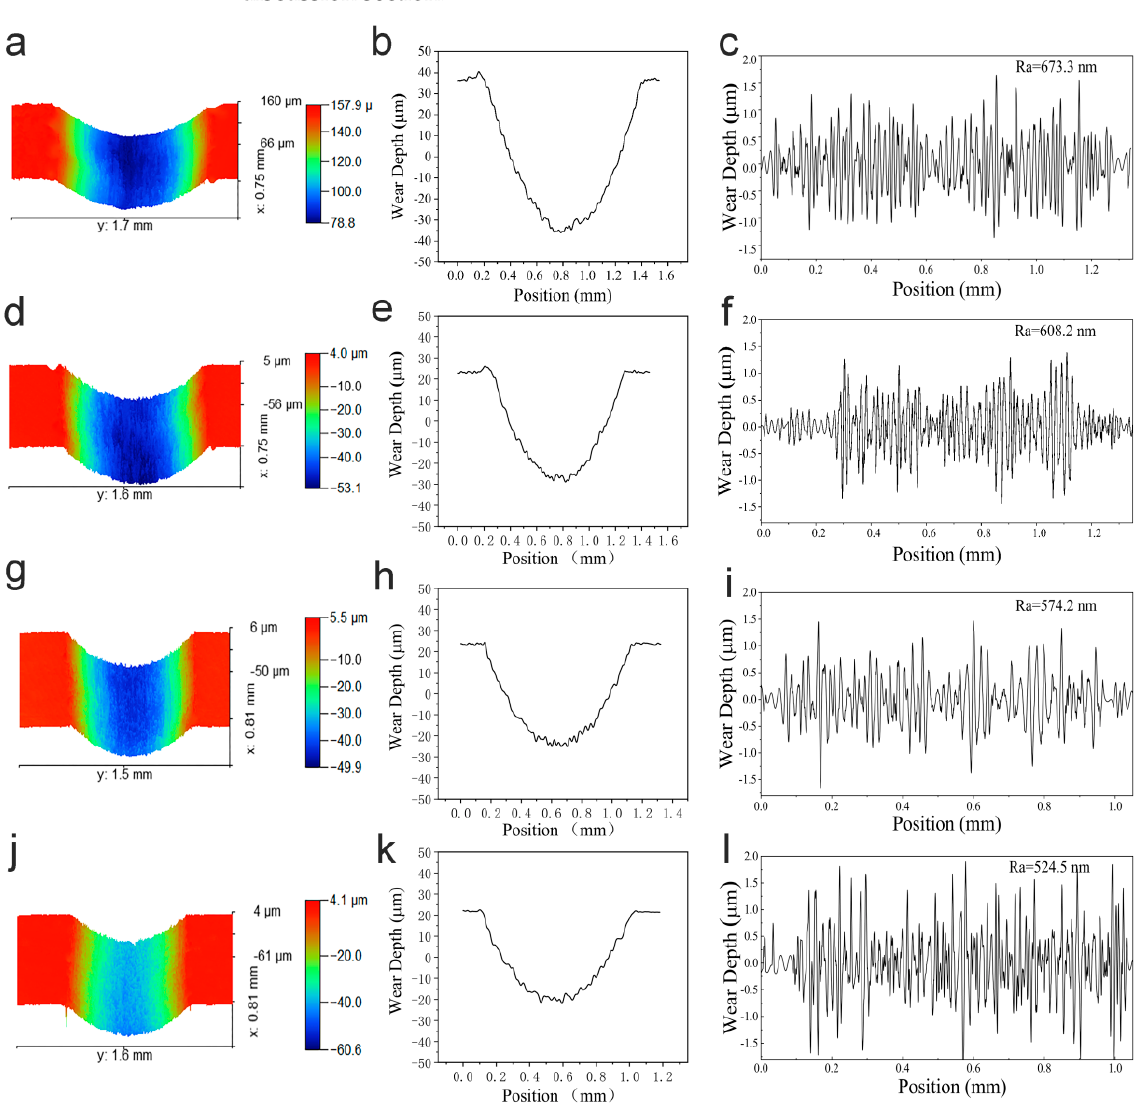
Figure 9. Three-dimensional topographies, the wear scar profiles and the worn surface roughness that are perpendicular to the sliding directions in the Al-5 wt.% CrCoNi composite ( a – c ), Al-10 wt.% CrCoNi composite ( d – f ), Al-15 wt.% CrCoNi composite ( g – i ) and Al-20 wt.% CrCoNi composite ( j – l